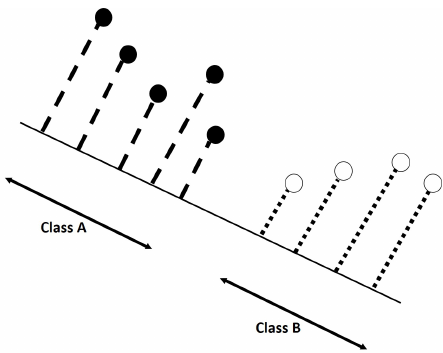
Figure 7. Scheme explaining the main objective behind LDA. Data samples in 2D ( N = 2, two features) are projected in a lower dimensions space (a line, 1D). The line must to be chosen in way that the projection maximizes the “separability” of the projected